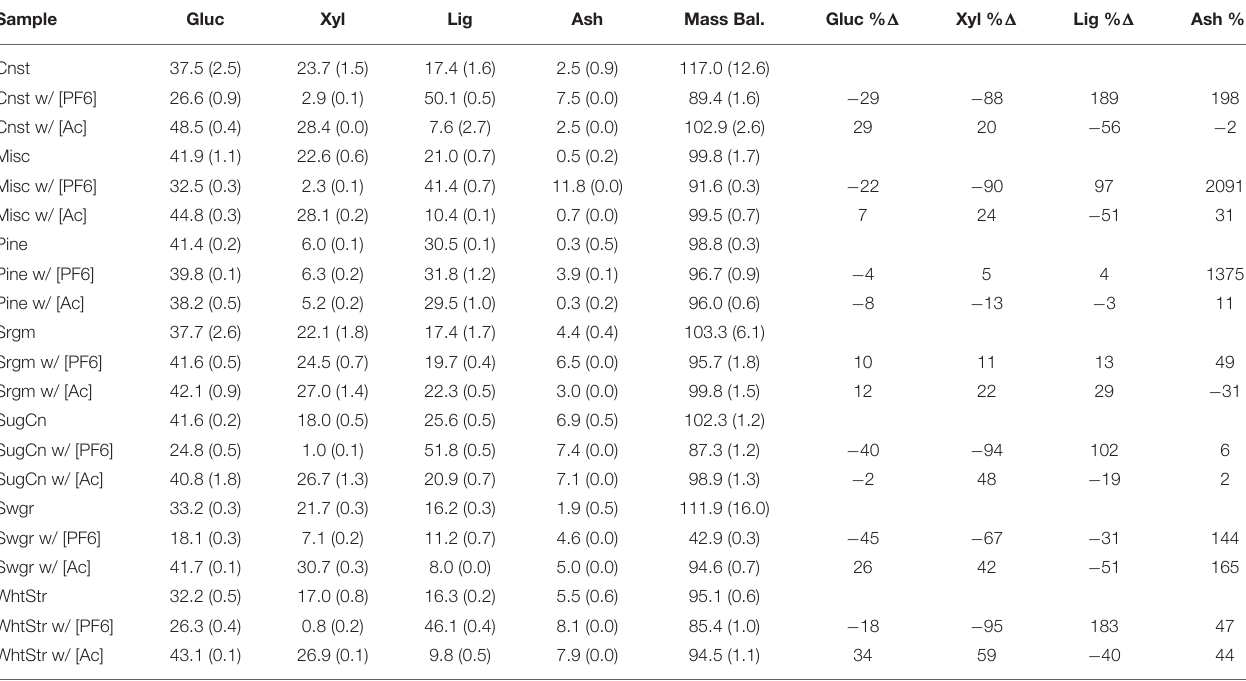
TABLE 4 | Compositional analysis of several raw and IL treated biomasses where the abbreviations are as follows: Cnst, corn stover; Misc, miscanthus; Pine, lodgepole pine; Srgm, sorghum; SugCn, sugarcane bagasse; Swgr, switchgrass; Wht Str, wheat straw. Sample